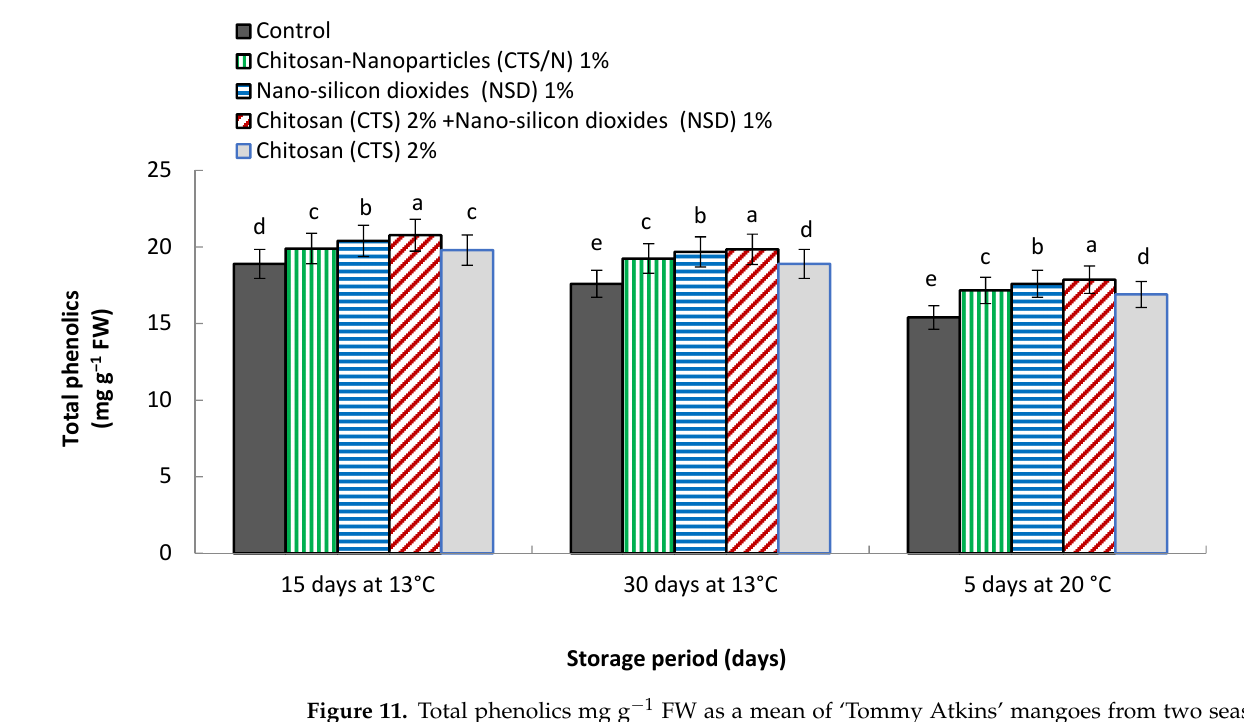
Figure 11. Total phenolics mg g − 1 FW as a mean of ‘Tommy Atkins’ mangoes from two seasons, stored at 13 ± 1 °C and 90–95% RH for 30 days. Afterward, the fruits were stored at 20 ± 2 °C and 70–75% RH for 5 days as the marketing period. Vertical bars indicate the standard error (SE) of the mean ( n = 5). The superscript letters followed by the same letters are not significantly different according to Duncan’s multiple range test at 0.05 level.